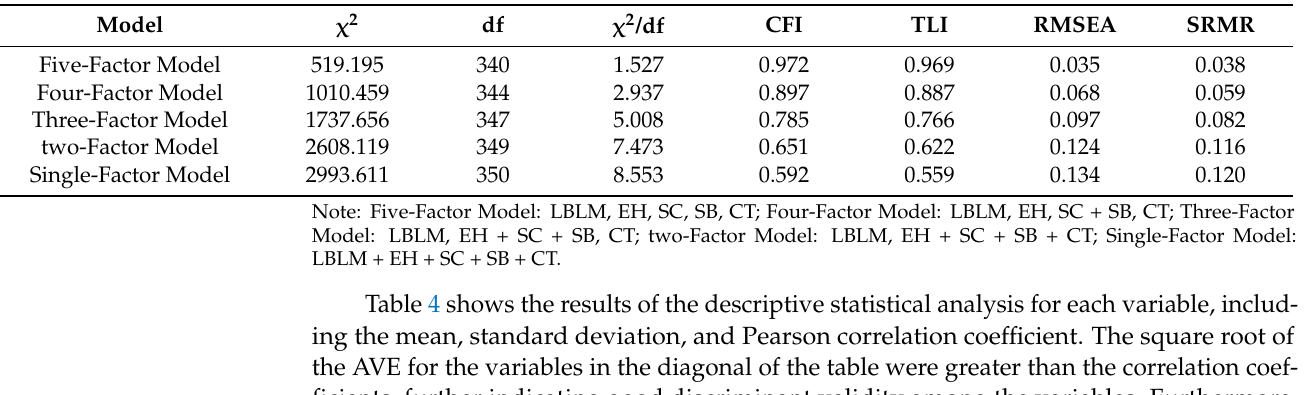
Table 3. Confirmatory factor analysis for testing structure validity (N = 422).